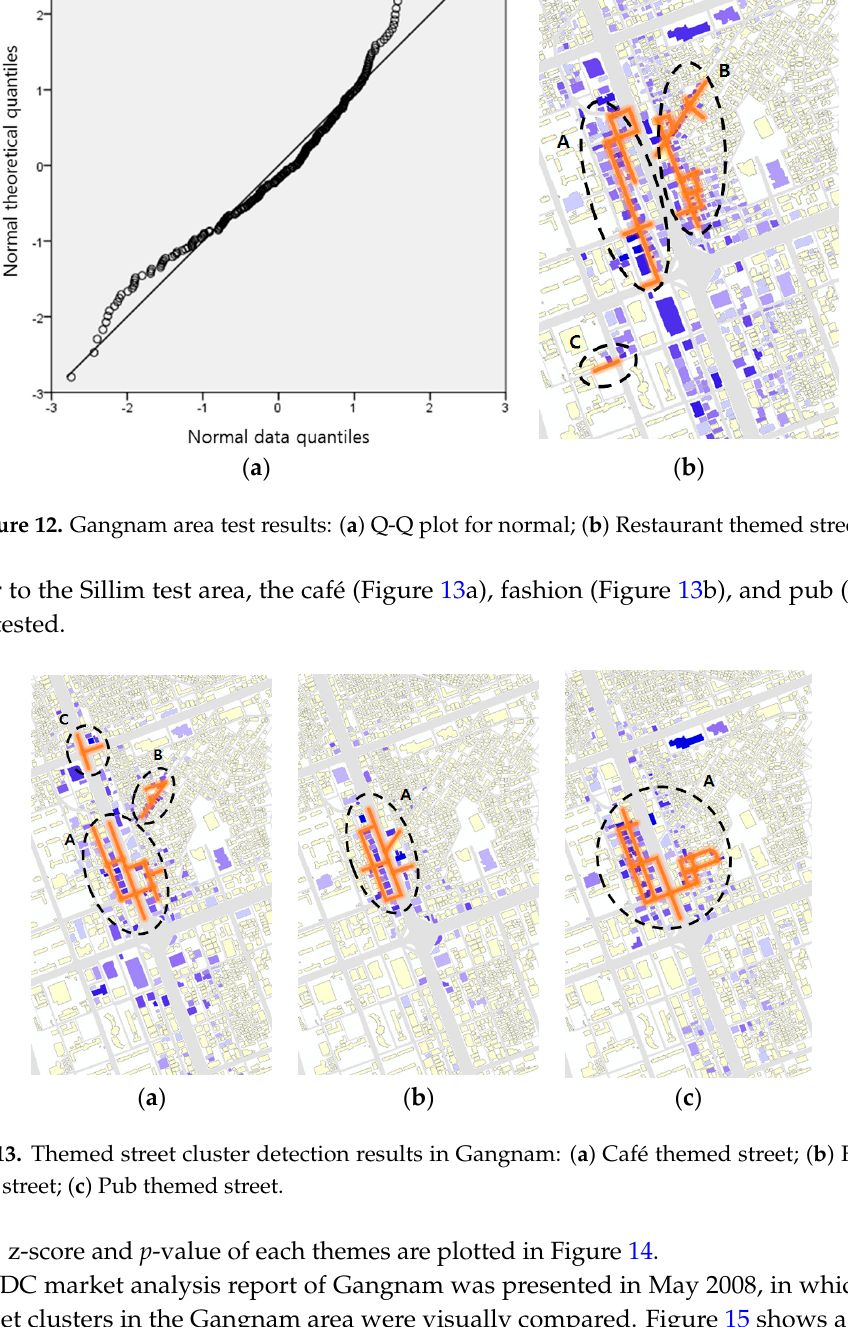
Figure 12. Gangnam area test results: ( a ) Q-Q plot for normal; ( b ) Restaurant themed streets.